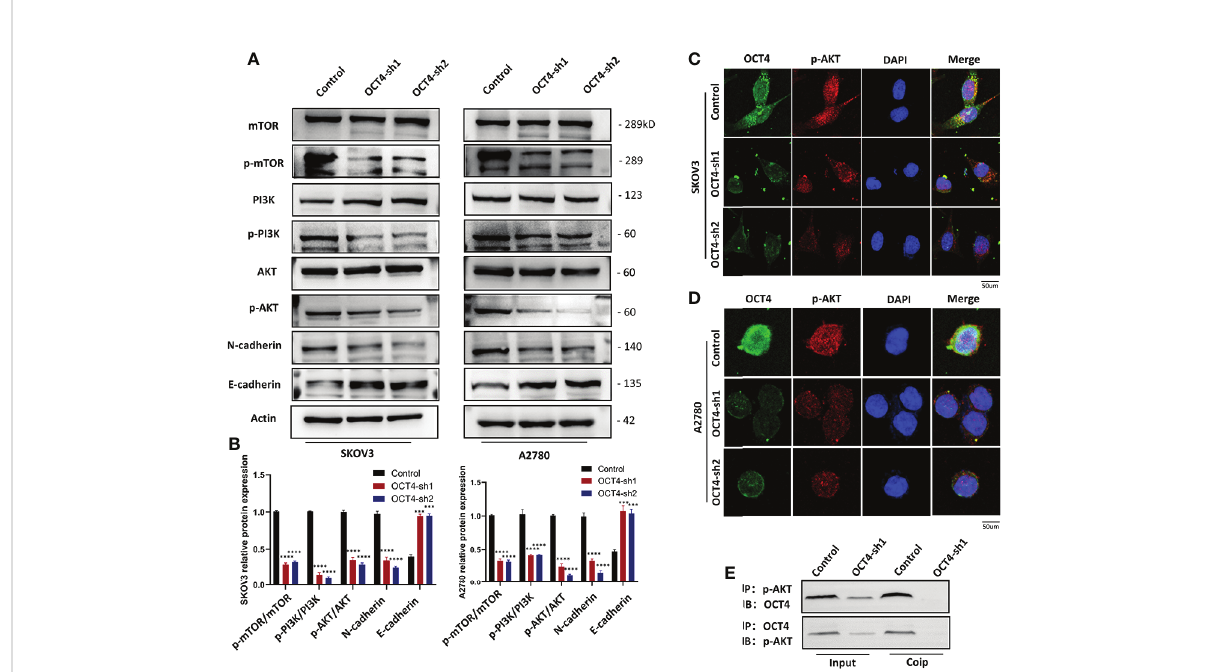
FIGURE 5 OCT4 in fl uenced the PI3K/AKT/mTOR signaling pathway in OC cells. (A, B) Western blotting was used to measure representative proteins and their relative expression levels in the PI3K/AKT/mTOR pathway. In addition, OCT4 knockdown inhibited the expression of the EMT pathway. (C, D) IF assays detected the relationship between OCT4 and p-AKT in OC cell lines. (E) CoIP of OCT4 with p-AKT in A2780 cell lines. The input represents the total protein extract used in IP. IB, immunoblotting; IP, immunoprecipitation. (Data were expressed as the mean ± SD. Signi fi cance was calculated using Student's t-test. ***P<0.001,